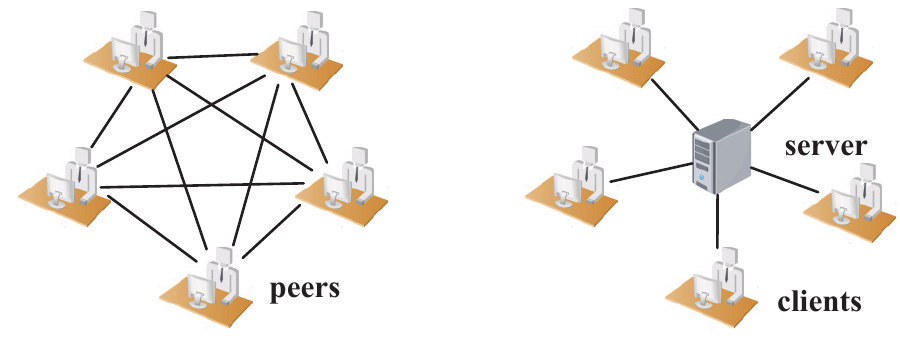
Figure 2. P2P network vs. centralized